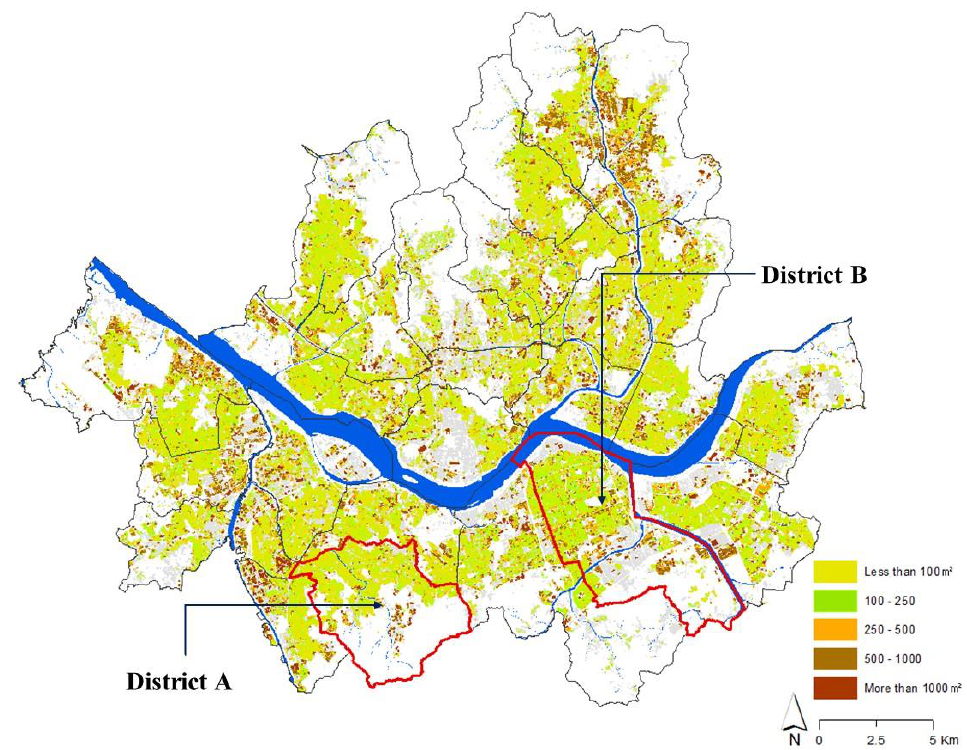
Figure 6. Analysis results of locations suitable for rooftop greening.